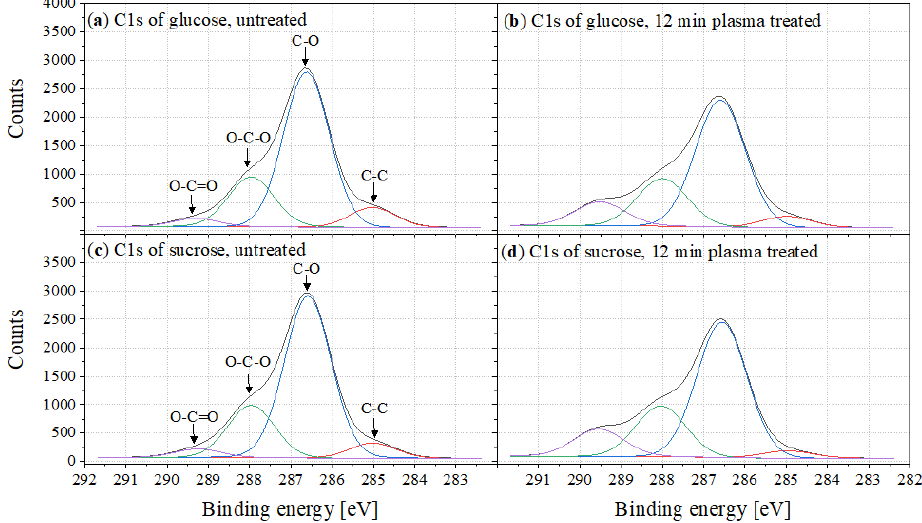
Figure 9. C1s peak of ( a ) untreated glucose, ( b ) 12min plasma-treated glucose, ( c ) untreated sucrose and ( d ) 12min plasma-treated sucrose.